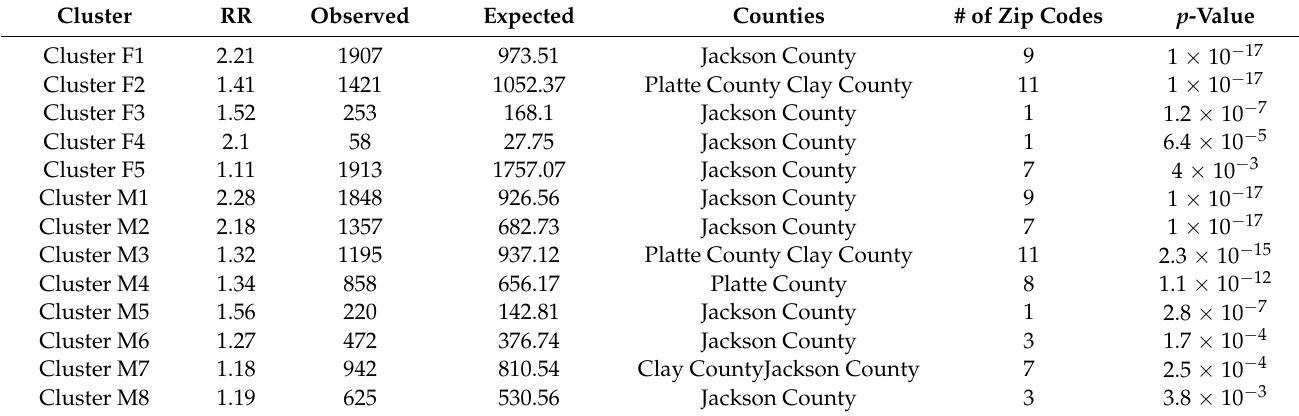
Table 4. Spatial clusters of COVID-19 with respect to female (F) and male (M) populations. Cluster RR Observed Expected Counties # of Zip Codes p -Value Cluster F1 2.21 Cluster F2